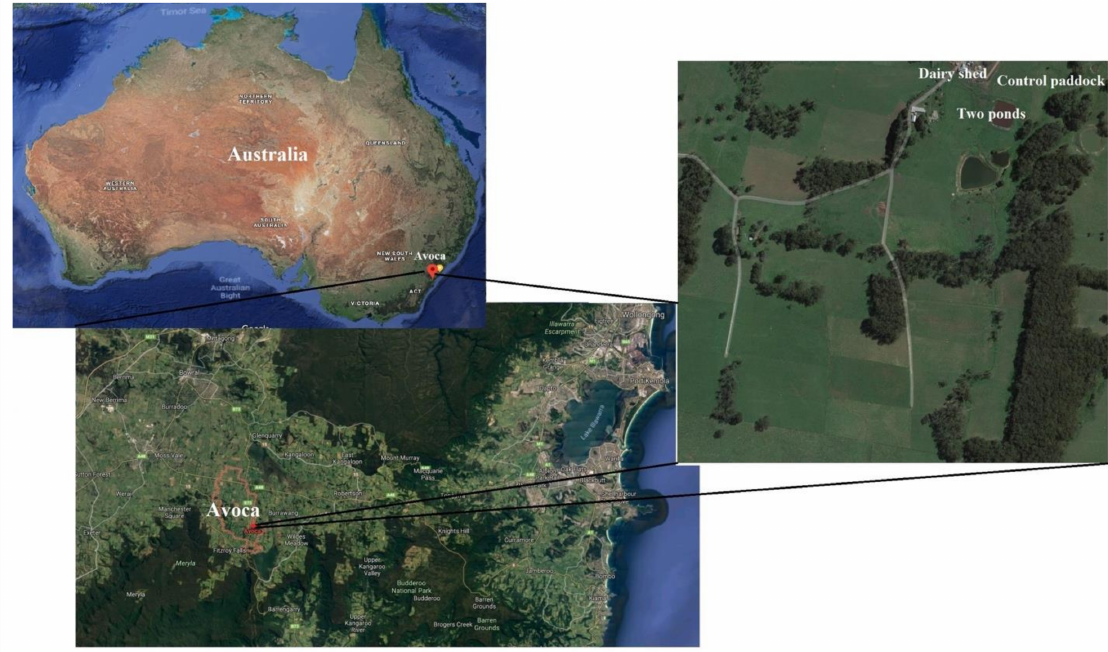
Figure 2. Study area showing the location of soil collection from a unfertilized paddock and two